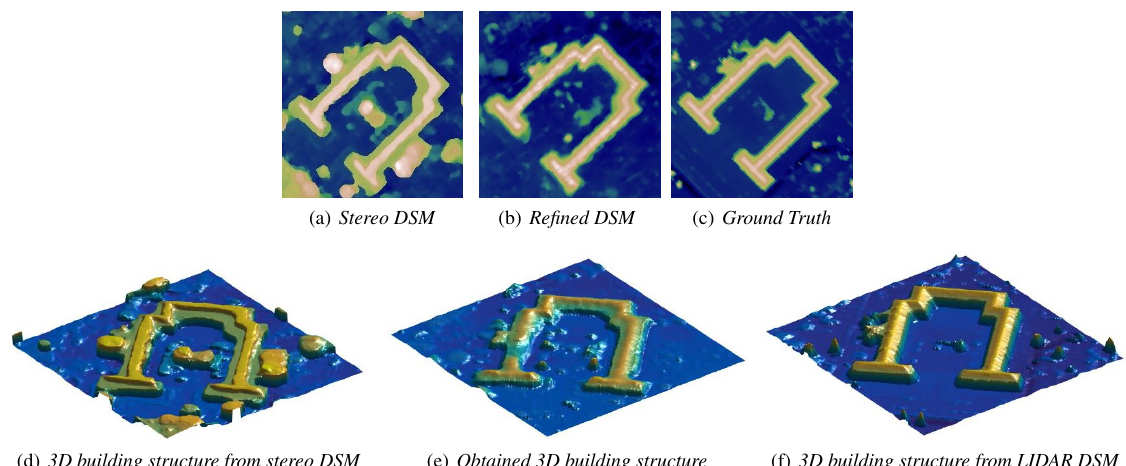
Figure 5. Example of the generated DSM with refined 3D buildings